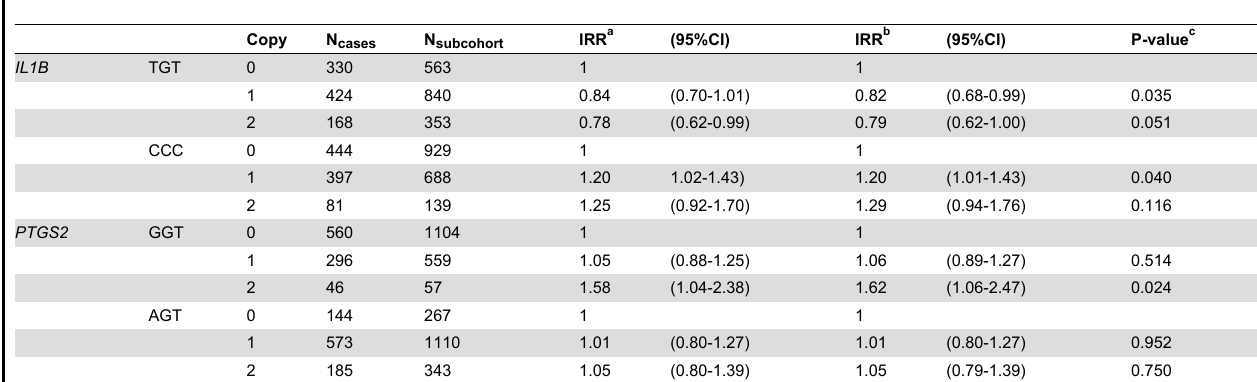
Table 3. Risk estimates for IL1B and PTGS2 haplotypes in relation to risk of colorectal